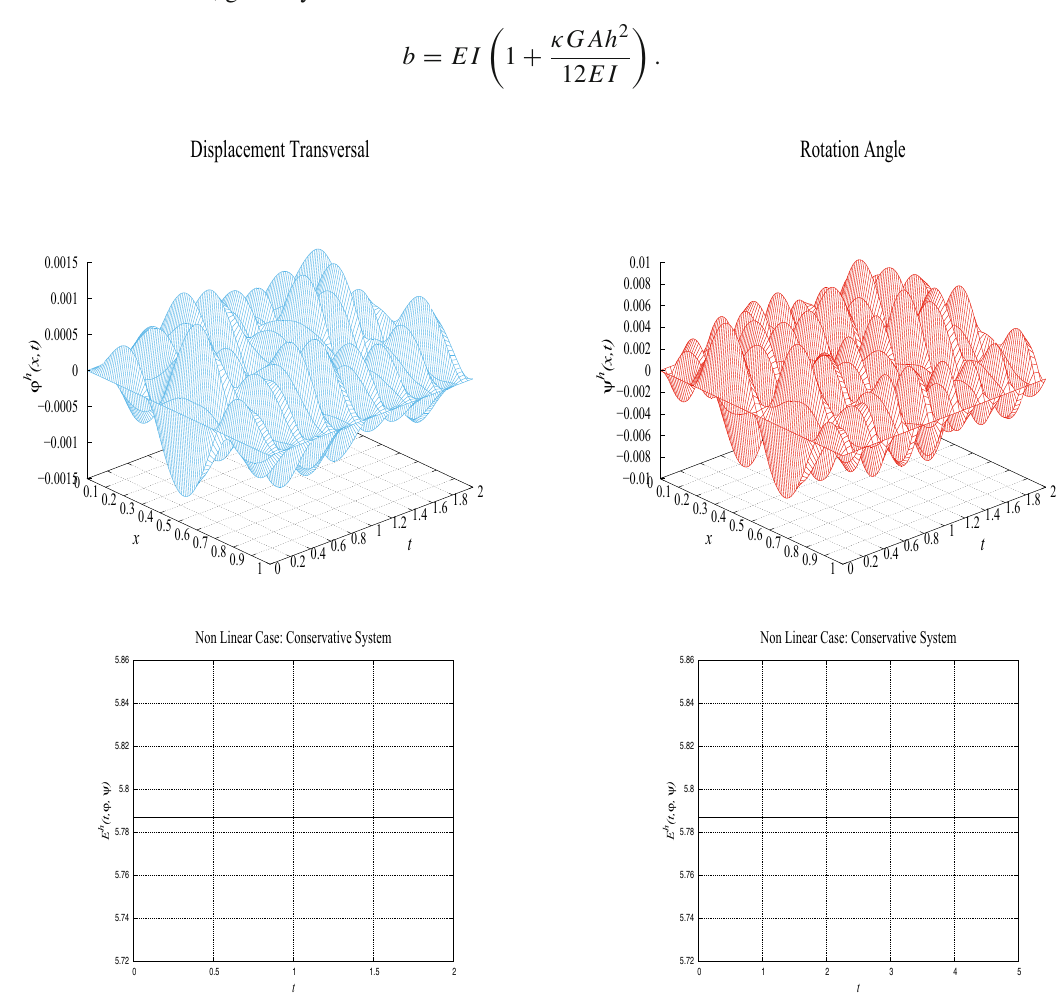
Fig. 1 Evolution of solutions: ϕ h ( x , t ), ψ h ( x , t ), respectively. Numerical energy at time 2.0 s and 5.0 s,